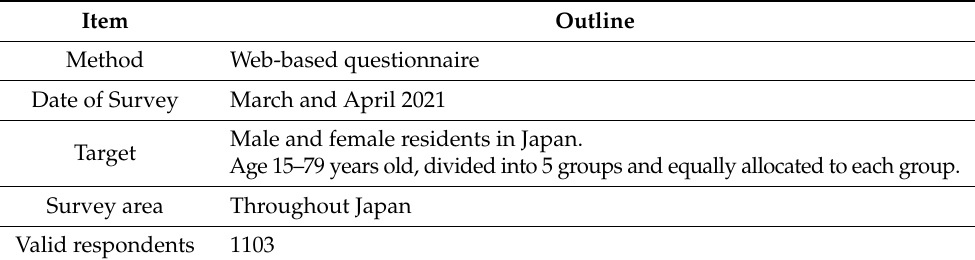
Table 1. Overview of the questionnaire